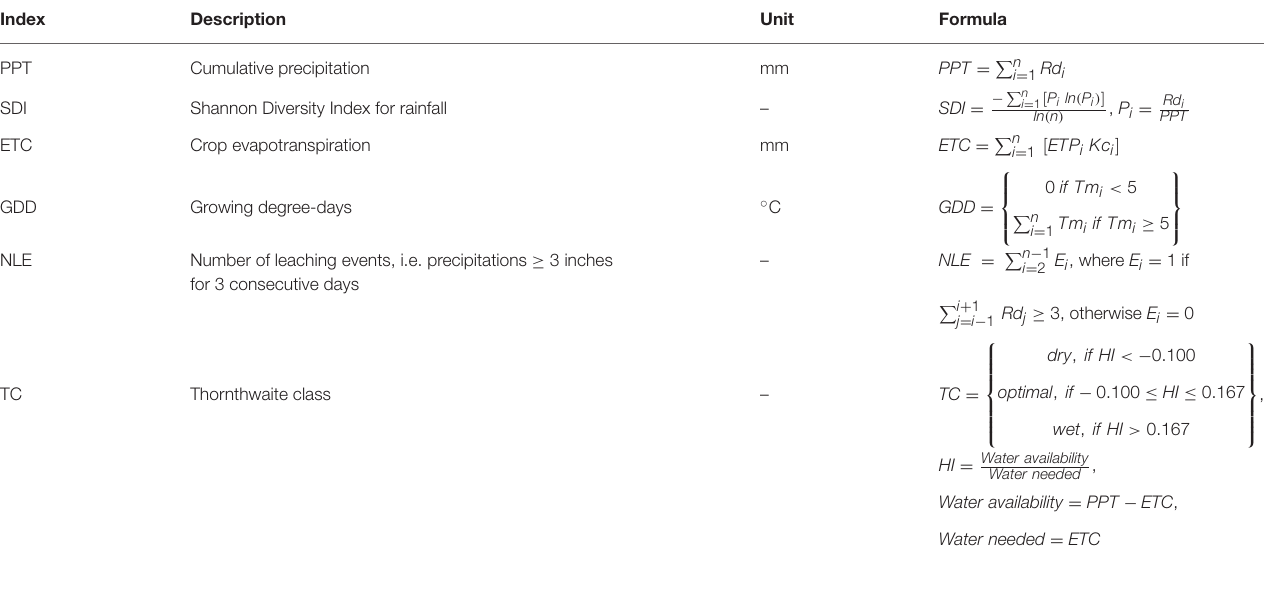
TABLE 3 | Equations to compute climatic indices: Rd is daily rainfall, n is the number of days, ETP is potential evapotranspiration, K c is crop coefficient depending on potato growth stage, and Tm is daily mean